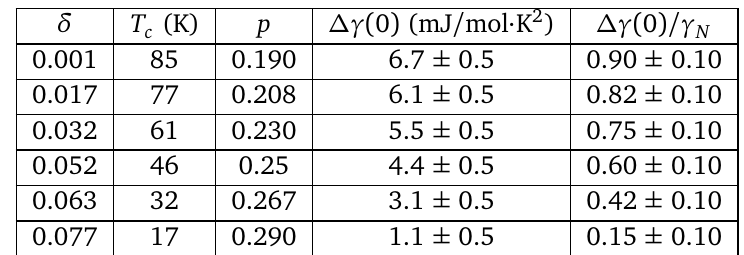
Table 5: Change in the electronic specific heat in OD Tl2201 upon entering the su- perconducting state as reported by Wade in Ref. [ 36 ] . The last column indicates the change in γ normalised to its normal-state value γ in Figure 1A.